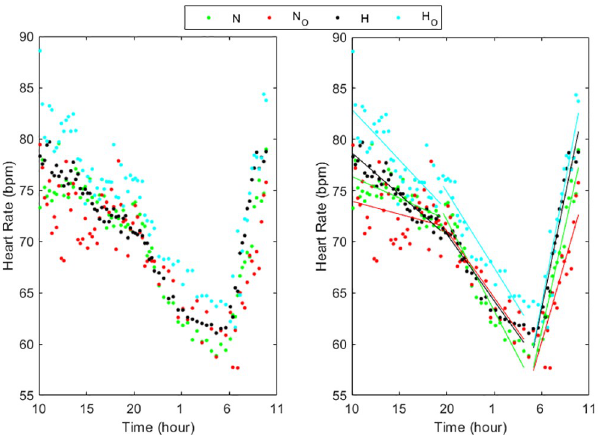
Fig 3. Circadian rhythms of HR in normotensive and hypertensive subjects with and without obesity (left panel) and their linear regression (right panel) in the three periods considered (10:00–20:00, 20:00–4:00, 5:00–10:00). N = Normotensive, N O = Normotensive obese, H = Hypertensive, H O = Hypertensive obese.